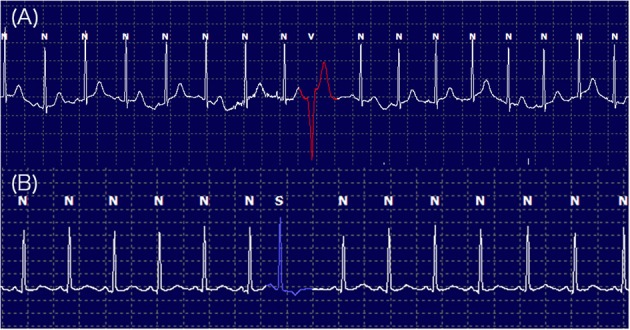
Twenty-hour Holter monitoring illustrating the frequencies and complexities of ventricular arrhythmia labeled as V (A) and supraventricular arrhythmia labeled as S (B) with normal QRS complexes labeled as N.